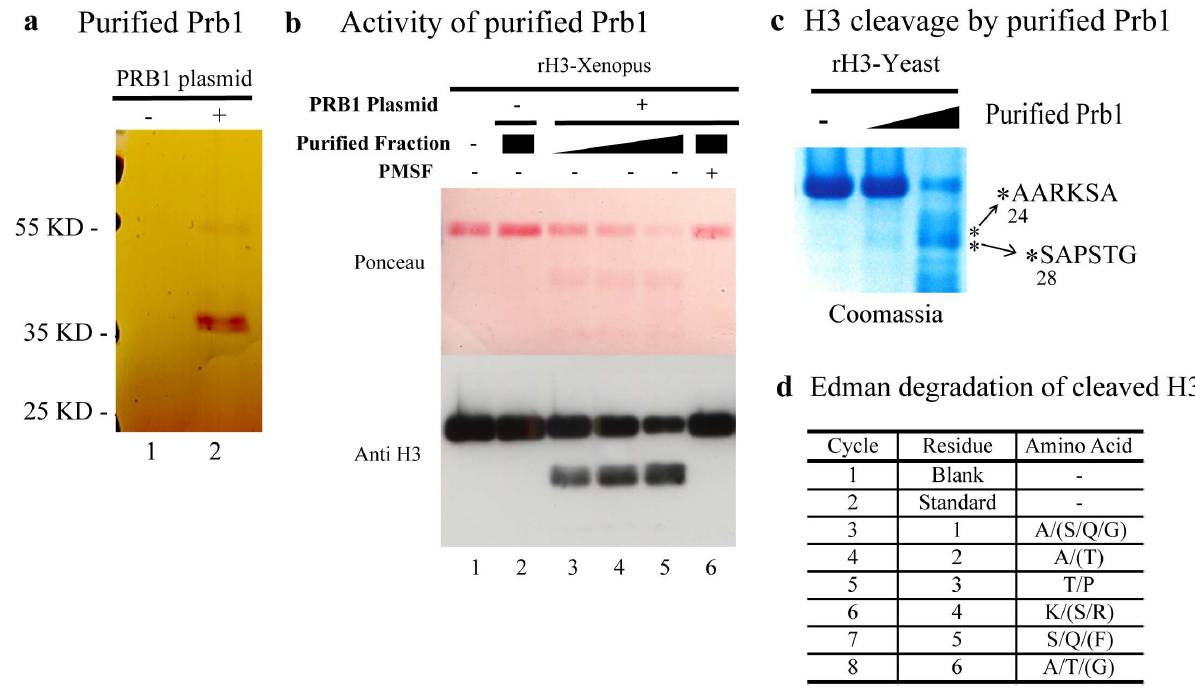
Figure 3. Purified Prb1 can cleave recombinant histone H3 at its N-terminus invitro. (a) Purification of Prb1 from yeast demonstrated by silver staining. Endopeptidase was purified from yeast with or without the PRB1 expression plasmid as described in the Materials and Methods. The protease was separated by SDS-PAGE and stained with silver. (b) Prb1 cleaves recombinant X. laevis histone H3 at its N-terminus in vitro. Purified Prb1 was assayed for endopeptidase activity with recombinant X. laevis histone H3. Purified protease from host strain (without plasmid) was used as control. (c) and (d) Prb1cleaves recombinant S. cerevisiae histone H3 between Lys23/Ala24 and Lys27/Ser28. (c) Recombinant S. cerevisiae histone H3 was incubated with purified Prb1, then H3 was separated by SDS-PAGE, transferred to PVDF and stained with Coomassie blue. The bands labeled with asterisk were excised and subjected to Edman degradation. (d) Results of Edman degradation sequencing. Cycle 1 is a blank run. Cycle 2 is the amino acid standard. Cycles 3–8 represent the six cycles of the clipped H3 corresponding to the N-terminal amino acid. X/Y/Z means that 2 or more residues were identified in each cycle. (X/Y) means that the identification of some residues was uncertain.